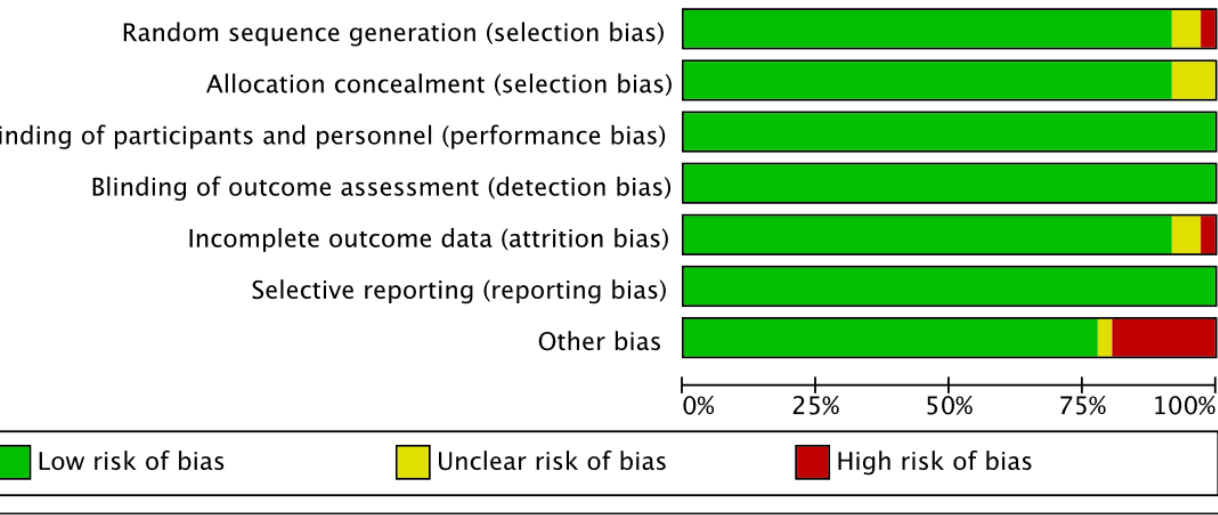
Figure 1. Risk of bias assessment